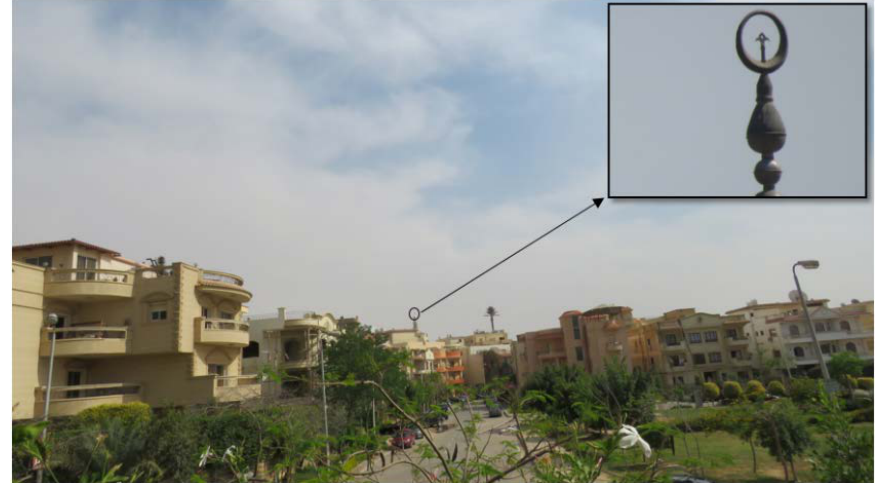
Figure 1. Example of 65× optical magnification power obtained using Canon Powershot Sx60hs camera for object about 330 m away.